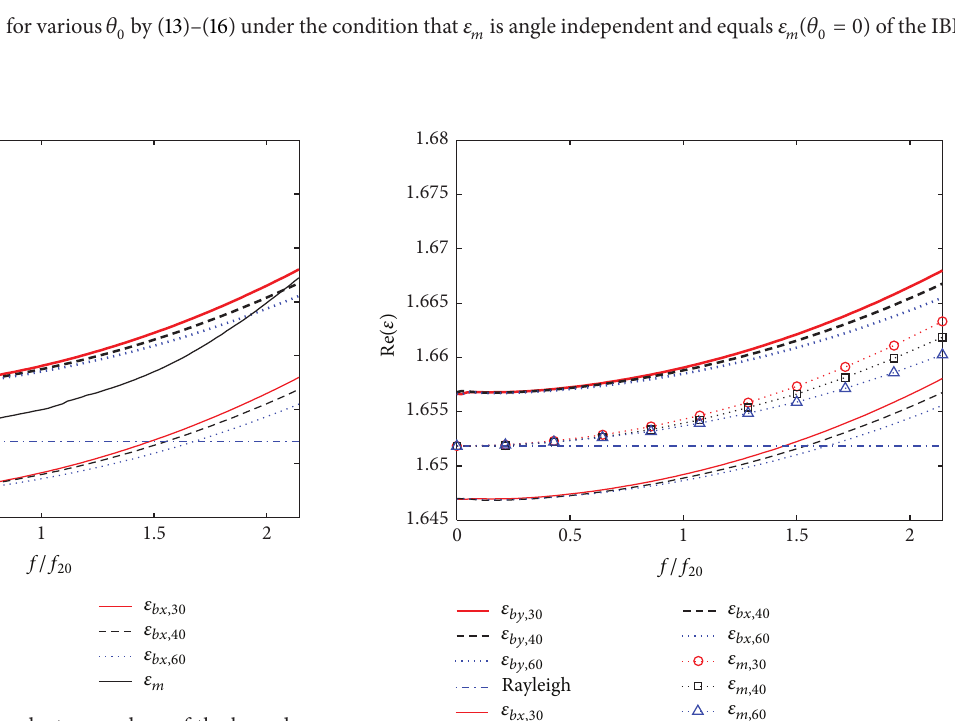
Figure 14: Retrieved angle-dependent 𝜀 𝑏𝑥 and 𝜀 𝑏𝑦 of the boundary layer and 𝜀 𝑚 of the inner layer for different incidence angles. The subscript numerals denote the incidence